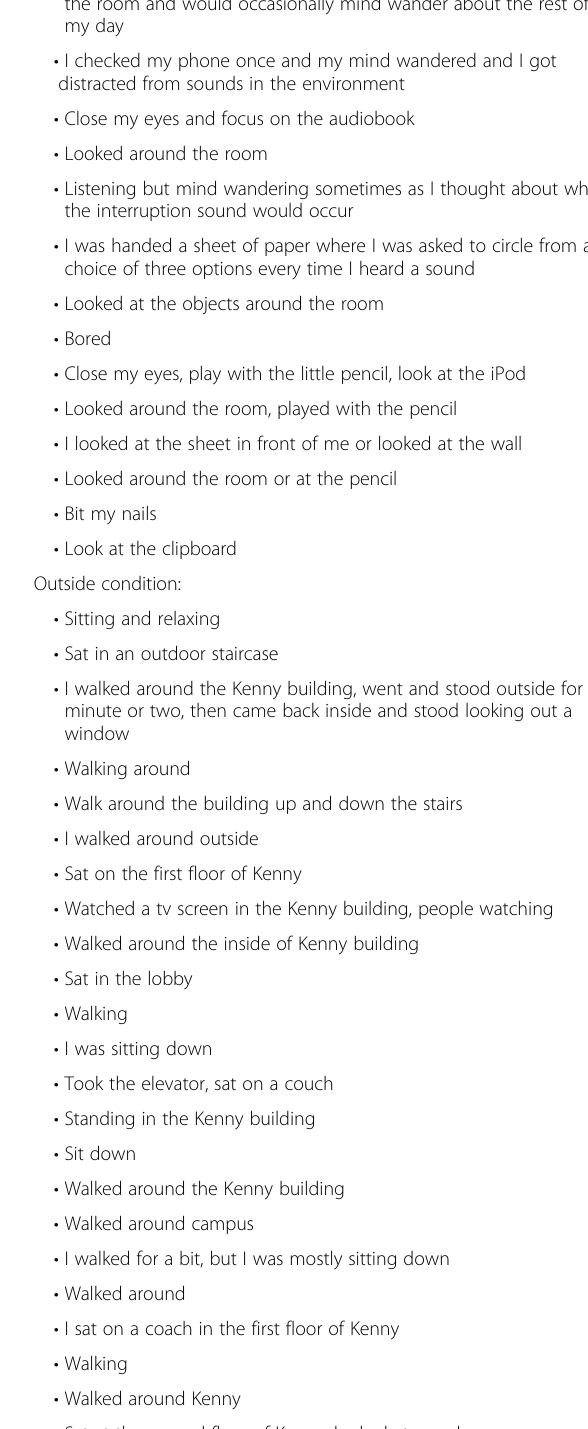
Table 3 Free-form responses to end-of-study questionnaire Question 1 ( “ What did you do while listening to the